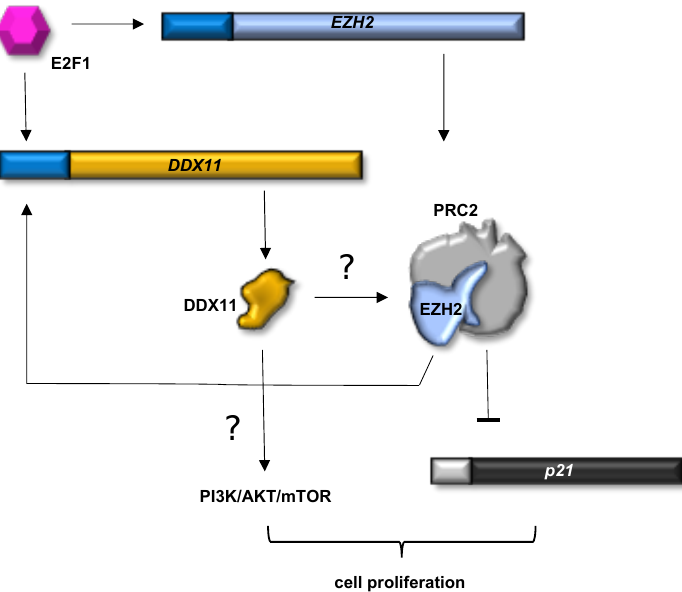
Figure 4. DDX11-mediated regulation of EZH2-p21 and PI3K/AKT/mTOR signaling pathways in HCC cells. The E2F1 factor promotes transcription of the genes coding for DDX11 and the Enhancer of zeste homolog 2 (EZH2), the subunit with methyl-transferase activity of the polycomb repressive complex 2 (PRC2). DDX11 has been proposed to activate the PI3K/AKT/mTOR signaling pathway and stabilize EZH2 by preventing its proteolytic degradation (question marks indicate that the underlying molecular mechanisms have not been elucidated). In turn, stabilized EZH2 cooperates with E2F1 to activate DDX11 gene transcription forming a positive feedback loop that leads to cell proliferation. Besides, inhibition of p21 gene transcription by EZH2 also contributes to cell growth.